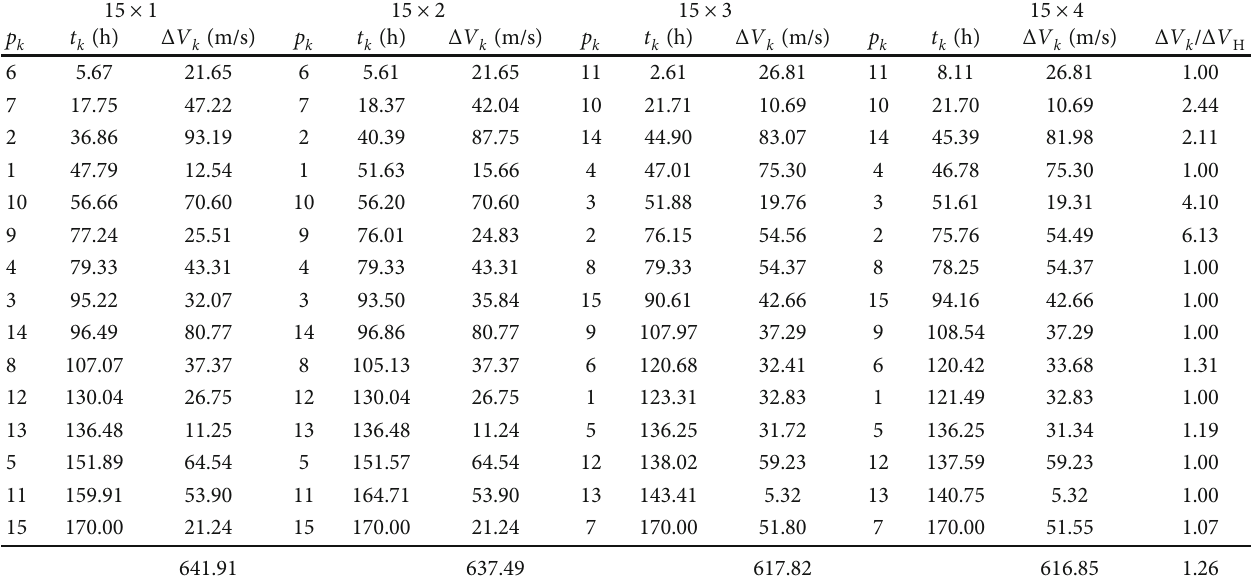
Table 4: Solutions of the 15-target problem after EOS time-free